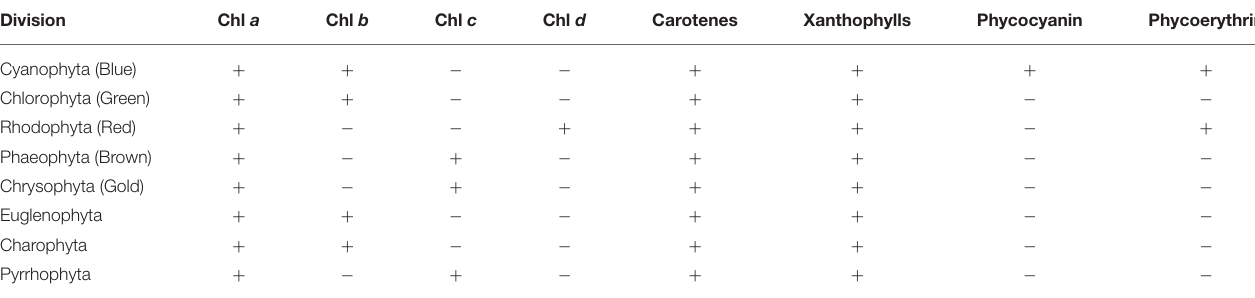
TABLE 1 | Pigment distribution table of the different algal divisions. Division Chl a Chl b Chl c Chl d Carotenes Cyanophyta